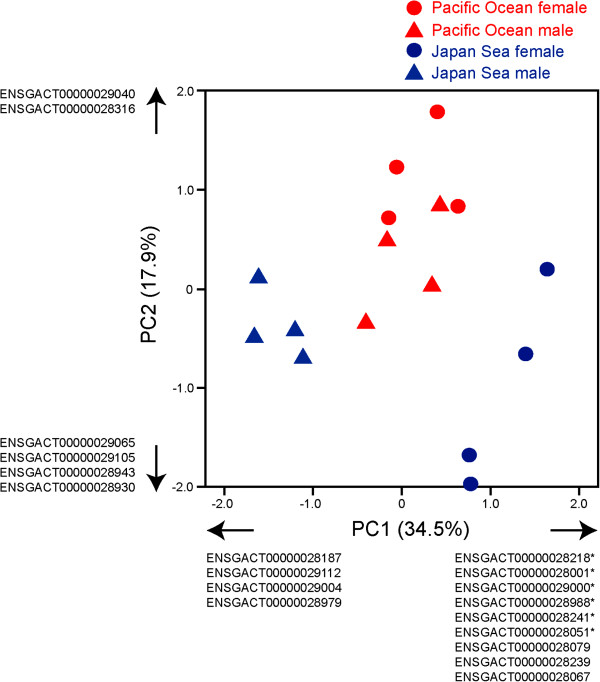
Principal component analysis (PCA). The first PC (PC1) and second PC (PC2) explained 34.5 and 17.9% of the variances, respectively. The loading components are shown in Table S2. The transcripts with loading component values larger than 0.75 and 0.70 for PC1 and PC2, respectively, are shown in the figure. The asterisks indicate the transcripts that were differentially expressed between the sexes by ANOVA with Bonferroni correction (Table 2).